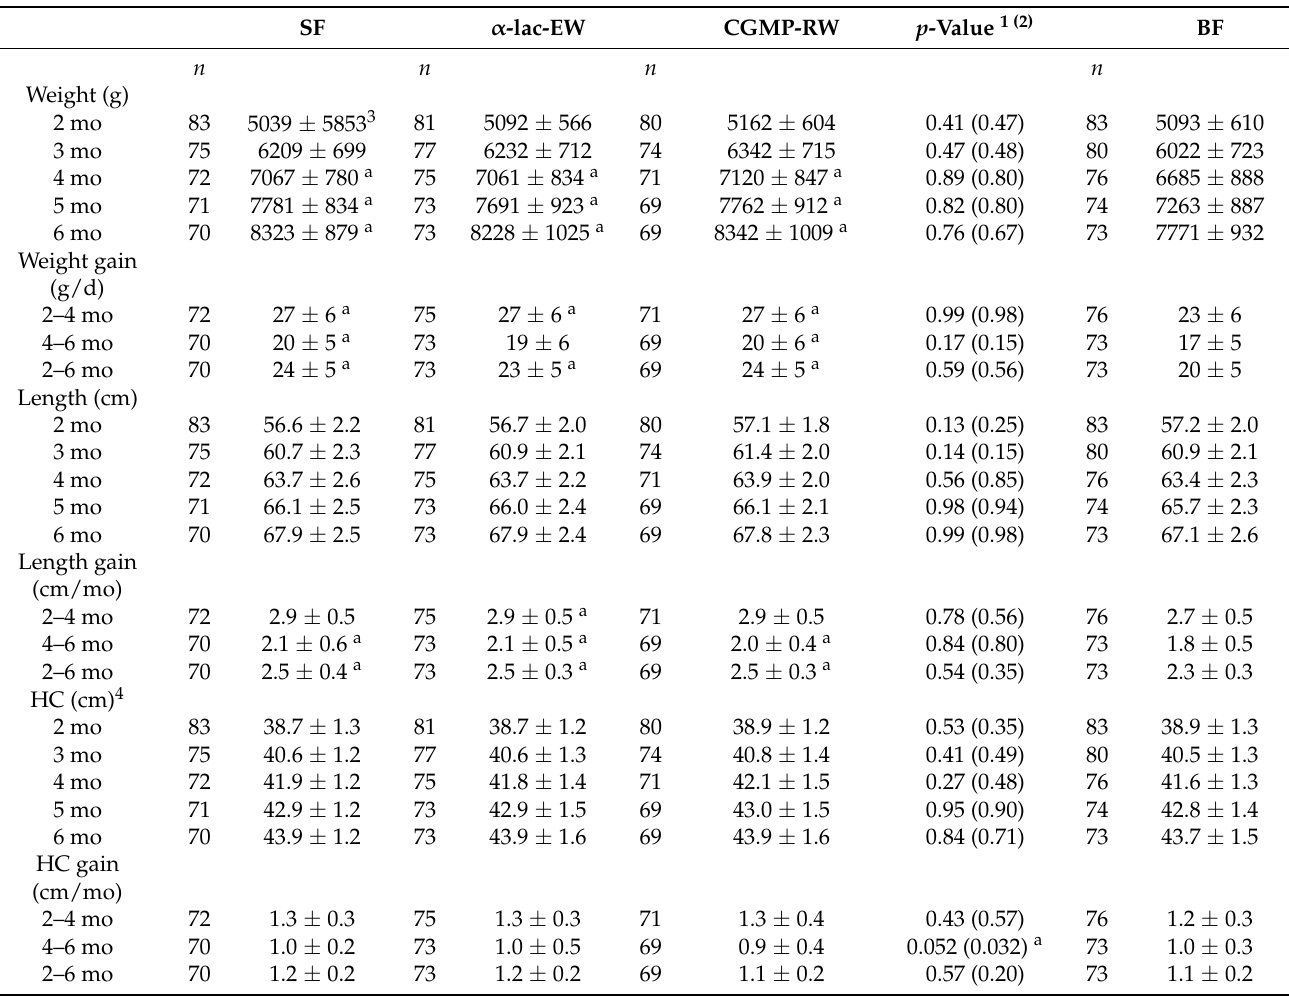
Table 4. Anthropometric data and growth velocity in infants fed formula (SF, α -lac-EW or CGMP-RW) * or breast milk (BF) during the intervention, ITT